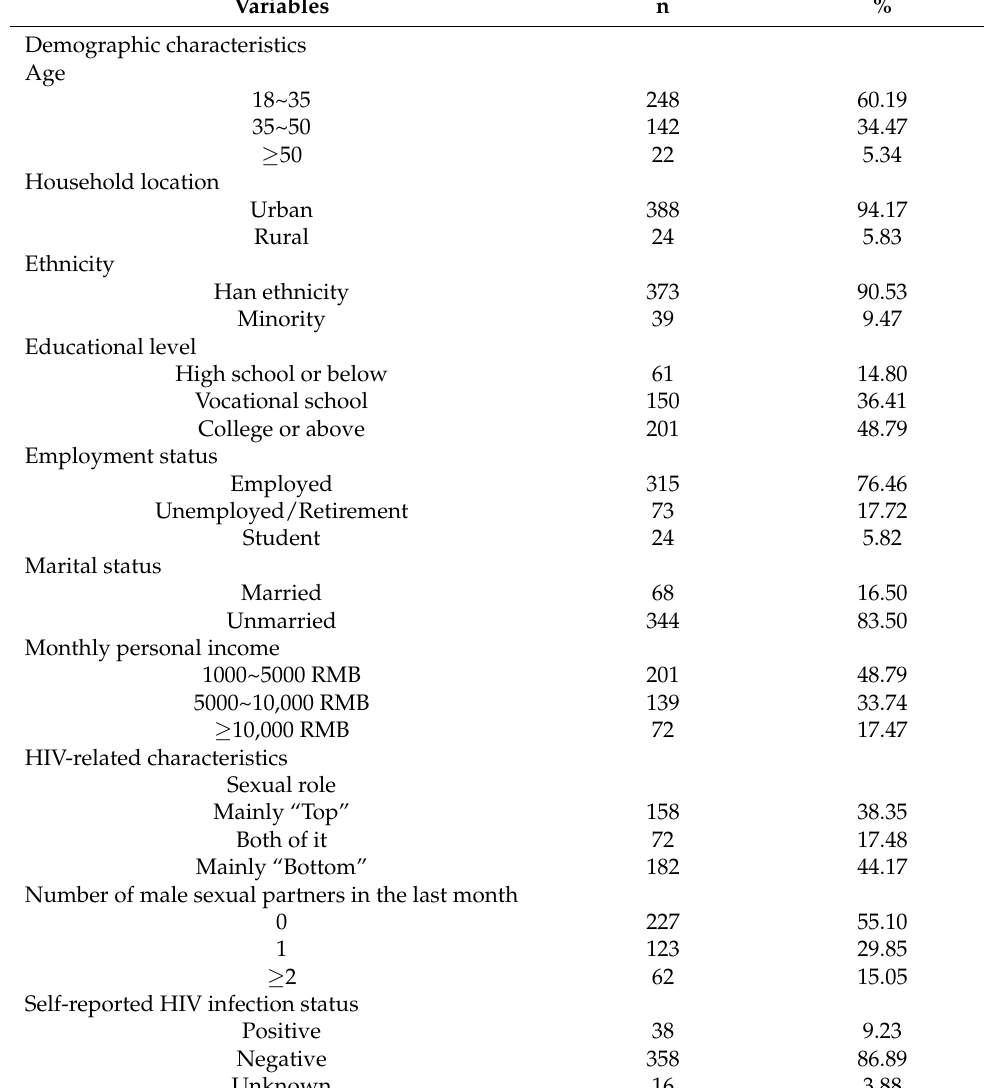
Table 2. Demographic and HIV-related characteristics of participants (n = 412).